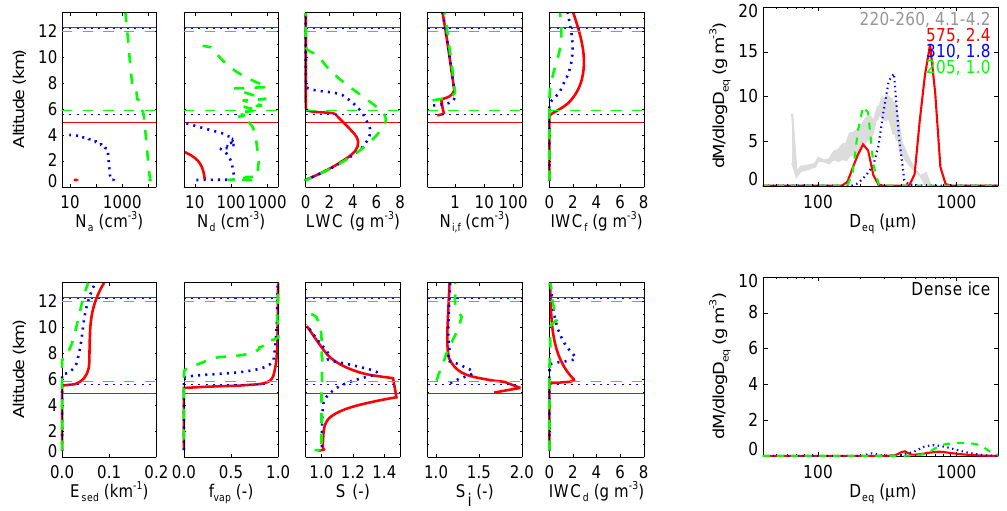
Figure 20. As in Fig. 19 but for non-entraining